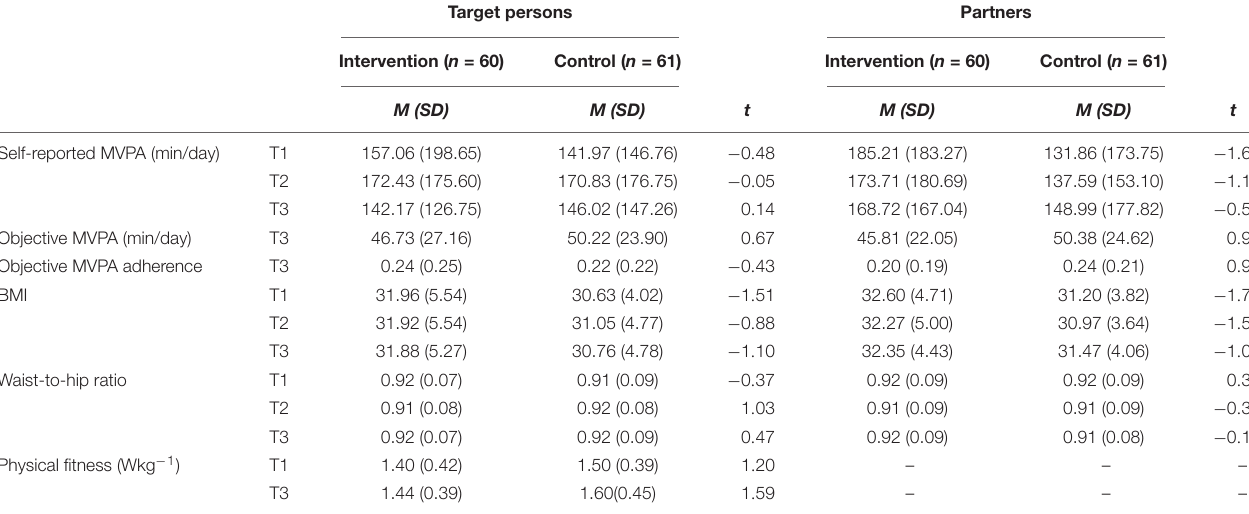
TABLE 2 | Descriptive statistics of primary and secondary outcomes for target persons and partners at baseline (T1), 1-month (T2) and 6-months (T3) follow-up.